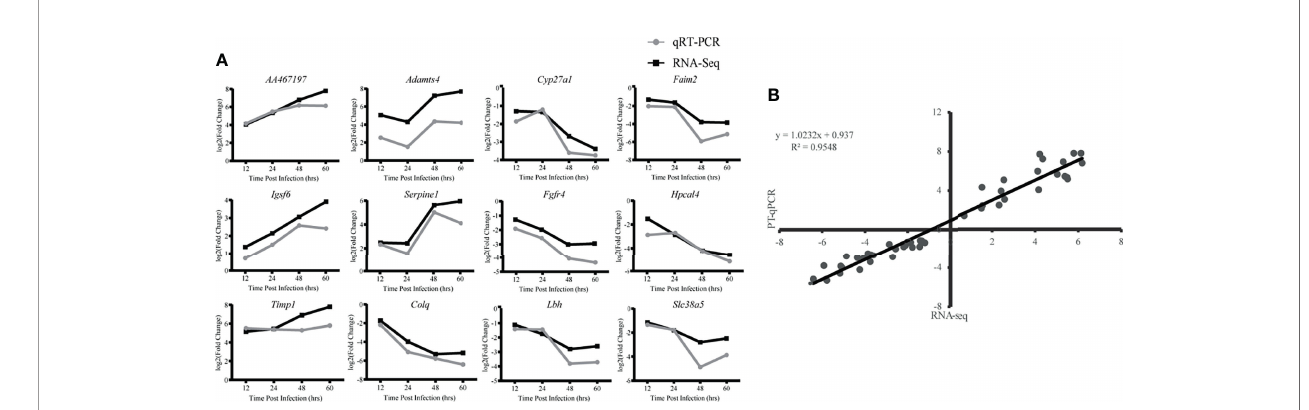
FIGURE 7 | Validation of RNA-Seq data by qRT-PCR. (A) Twelve differentially expressed genes (DEG) were selected for veri fi cation. Relative quantity of gene expression (fold change) for each gene was calculated with the comparative 2 - DD CT method. The y-axis shows the fold changes of different infection stages compared to the beginning point, with positive values indicating up-regulation and negative values indicating down-regulation. Each data point was obtained from three biological replicates. (B) Correlation of fold change analyzed by data obtained using qRT-PCR (x axis) with RNA-Seq platform (y axis). Correlation analysis was performed using GraphPad software